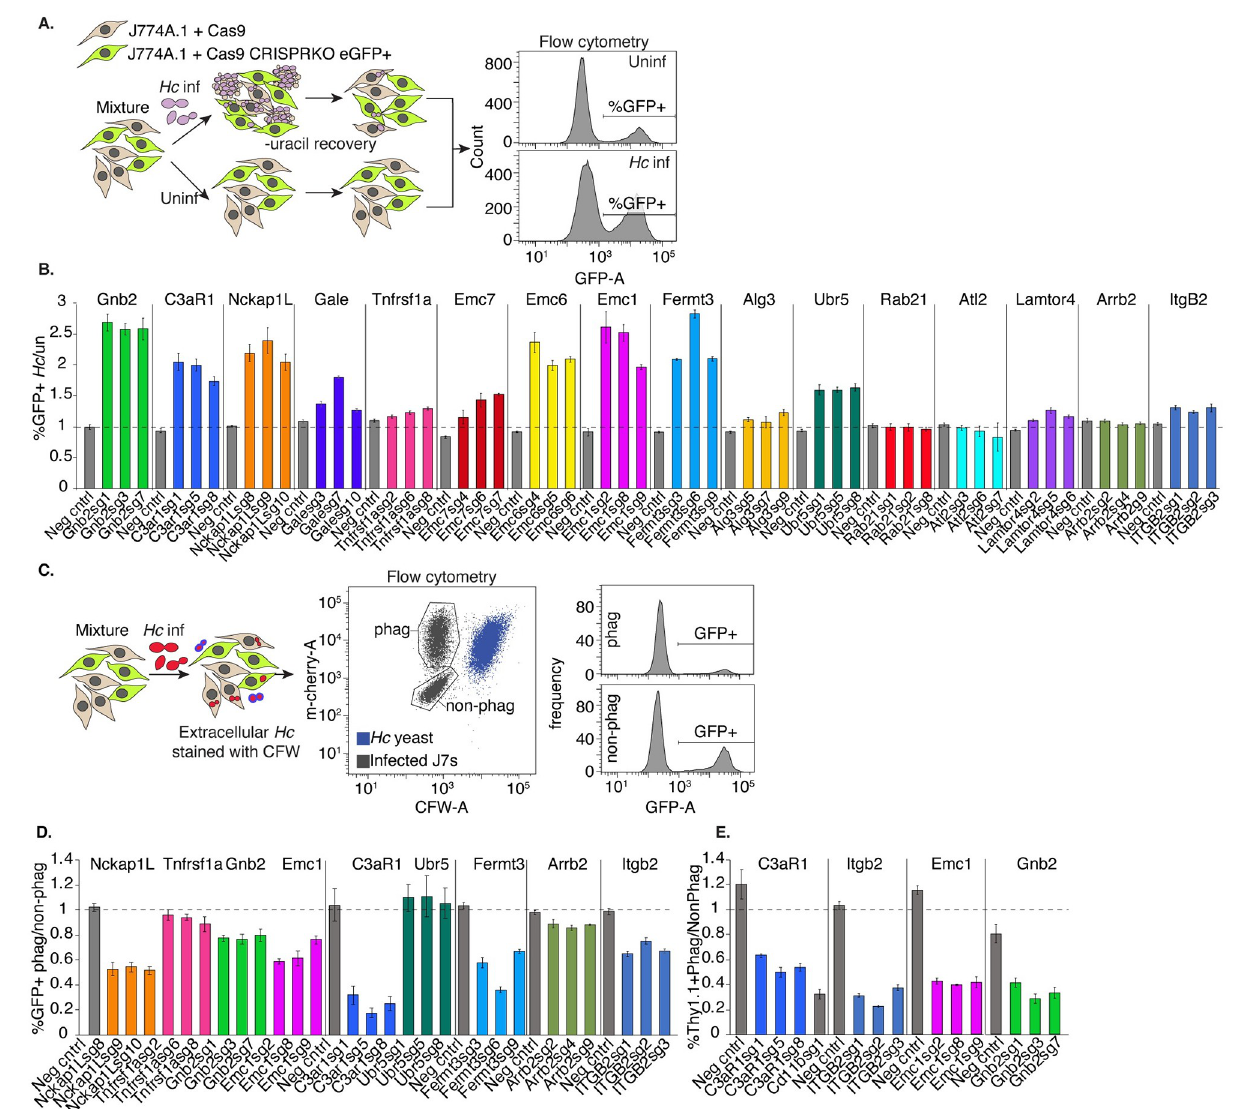
Fig 2. Identification of genes required for phagocytosis of yeast in J774A.1 cells and primary macrophages. A. Diagram of approach used to individually validate the role of a gene in macrophage susceptibility to Hc infection. A mixture of WT (GFP-) and CRISPRKO (GFP+) J774A.1 cells were challenged with Hc yeast in the presence of uracil, and allowed to recover. Uninfected cells from the same mixture were passaged in parallel, and the percentage of mutant cells in the Hc infected pools was compared to that of the uninfected pools via flow cytometry (n = 3 biological replicates). B. Enrichment of gene-targeting guides in the Hc infected pool relative to the control pool, compared to that of non-targeting guides. C. Diagram of approach for determining the role of a gene in phagocytosis of Hc . A mixture of WT (GFP-) and CRISPRKO (GFP+) J774A.1 cells were infected with mCherry-expressing Hc yeast. Non-internalized yeasts were excluded using calcofluor white staining. Flow cytometry was used to determine the representation of mutant cells in the phagocytic compared to the non-phagocytic populations (n = 3). D. Identification of genes required for phagocytosis of yeast in J774A.1 cells using GFP expression to measure enrichment of sgRNA-expressing cells. E. Validation of gene involvement in BMDM phagocytosis of yeast using CRISPRKO BMDMs (Thy1.1+). A mixture of transduced (Thy1.1+) and untransduced (Thy1.1-) BMDMs were similarly infected with yeast and stained with calcofluor white and a Thy1.1 antibody to determine the representation of mutants in the phagocytic and non-phagocytic populations (n = 3 biological replicates). yeast detected with a fluorescent antibody (Fig 3C), and Coccidioides posadasii arthroconidia labeled with FITC ( Cp ) (Fig 3D), and determined the extent of phagocytosis over time. We also tested phagocytosis of FITC-labeled zymosan (Fig 3B), a cell-wall extract of Saccharomyces cerevisiae . We used calcofluor white staining to distinguish between intracellular and